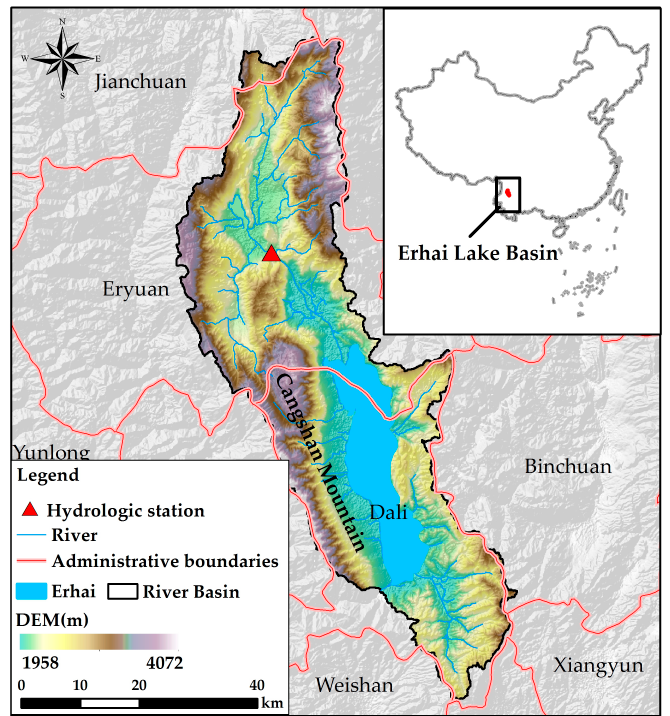
Figure 1. Location of the Erhai Lake Basin (ELB), Southwest China.